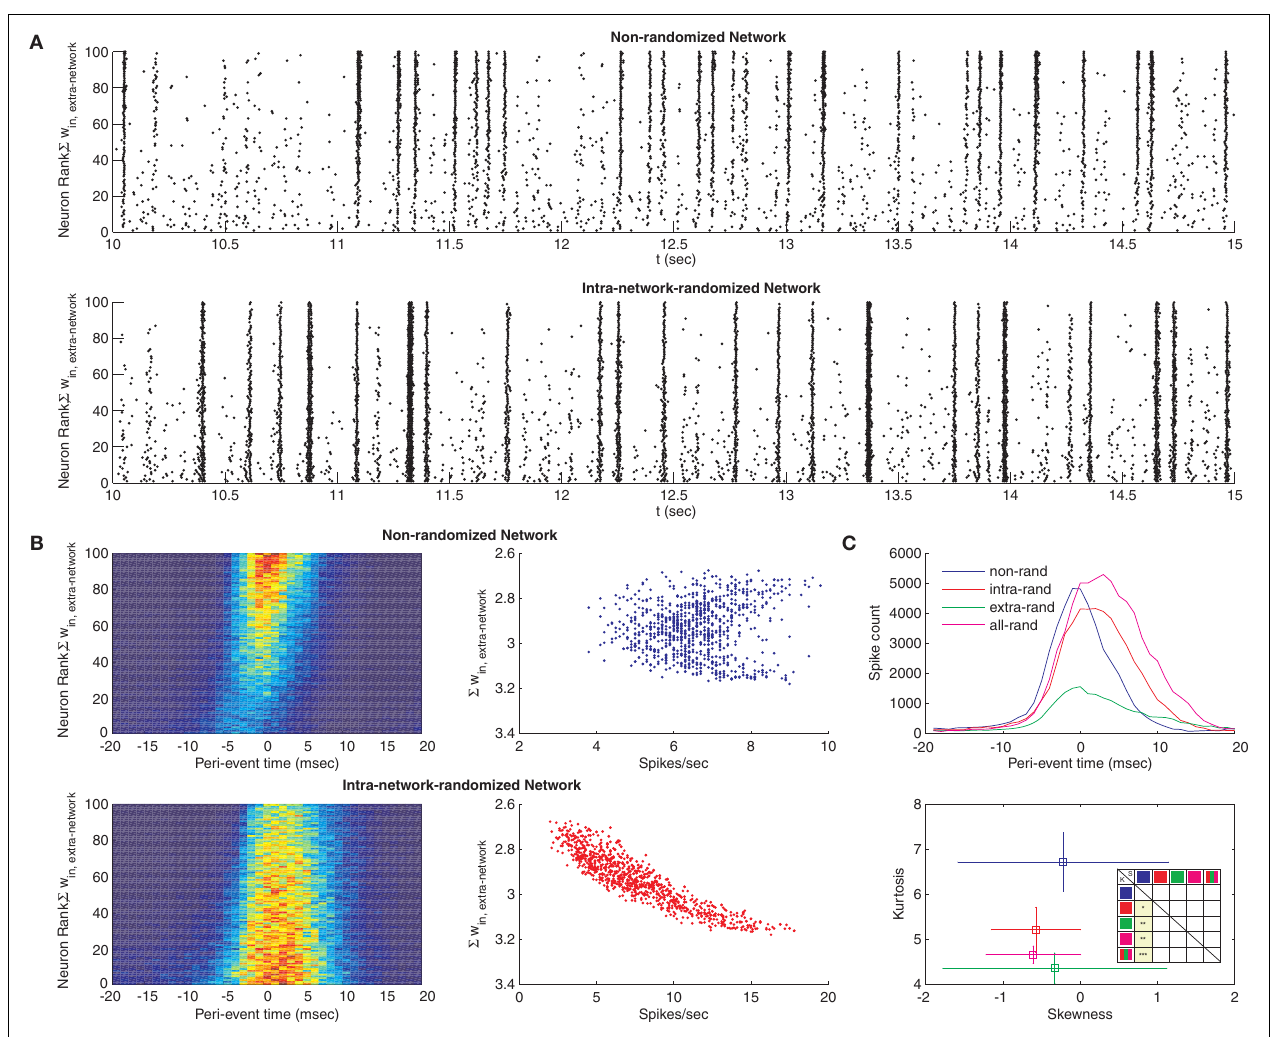
across all simulations and all neurons for the STDP network (blue) and three surrogates, in which the intra-network connections (red), extra-network connections (green) or both (magenta) were randomized (top). Skewness versus kurtosis of these histograms averaged across eight separate simulations each (bottom, error bars show standard deviation) indicates the network distribution of spikes is more peaked with more spread for the STDP- learned topology. Inset table shows P -values of unpaired t -tests of skew (upper right triangle) and kurtosis (lower left triangle) measurement distributions from each of eight simulations between each of the four conditions, plus the entire distribution of randomized networks (red, green, magenta, icons). Squares colored yellow are signifi cant, with stars indicating P -values’ orders of magnitude (from P <